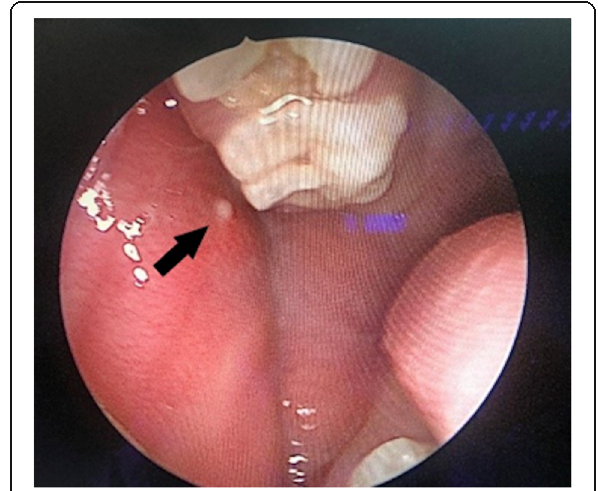
Fig. 2 Intraoral examination noted pus discharge from the right Stensen duct opening